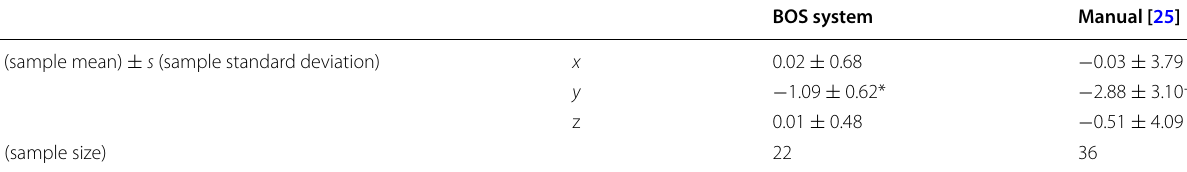
Table 2 Surgical changes in condylar position after surgery, using BOS system or intended manual condylar positioning